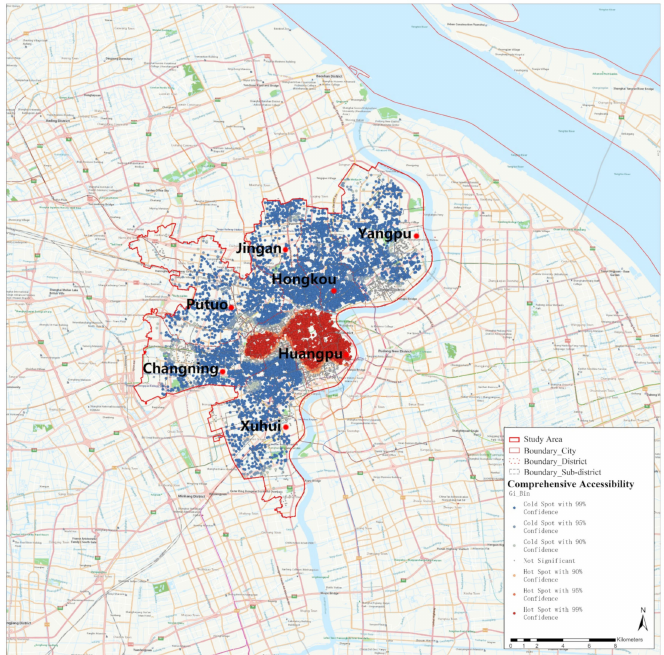
Figure 4. Results of cold and hot spot analysis: distribution of comprehensive accessibility.